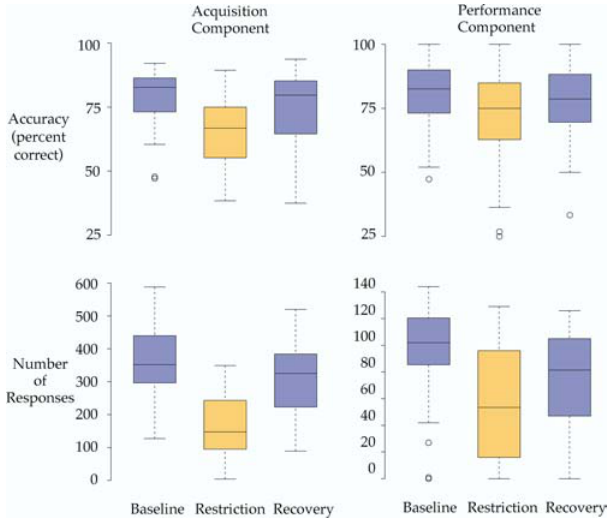
Figure 6. Operant Behavior and Sleep Restriction Average values for accuracy and the total number of responses on the acquisition and performance tasks are shown for the 3 d preceding sleep restriction, the 3 d of sleep restriction, and the 3 d following sleep restriction; boxes represent the 25th to 75th percentile of data with the median indicated by the line across the box. The ‘‘ whiskers ’’ extend from the quartiles to the most extreme value less than 1.5 times the interquartile range. Points outside the whiskers are plotted with small circles. Accuracy and total number of responses decreased significantly in both the acquisition and performance tasks following sleep restriction ( n =